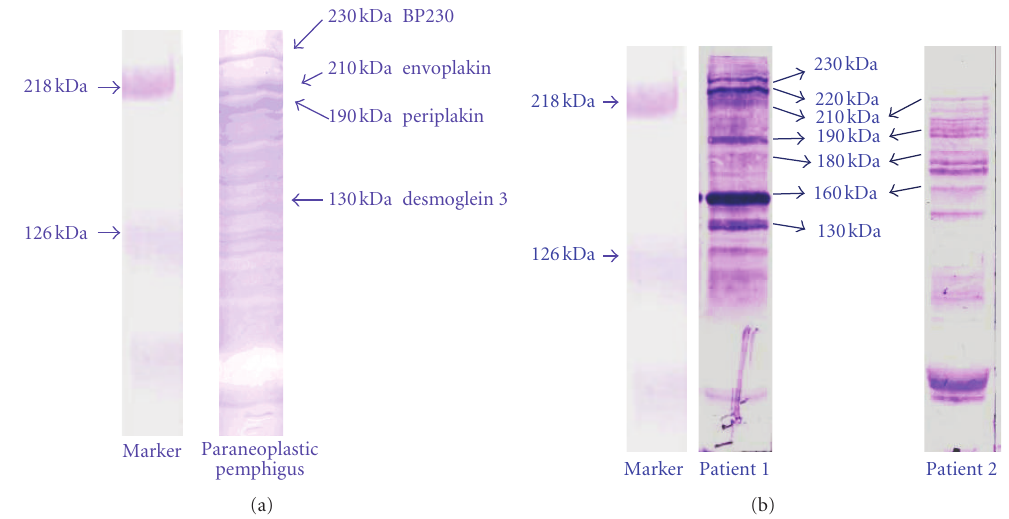
Figure 2: Western blot investigations. (a) A “ladder” configuration can be seen in paraneoplastic pemphigus. (b) A “ladder” configuration of paraneoplastic pemphigoid on western blot